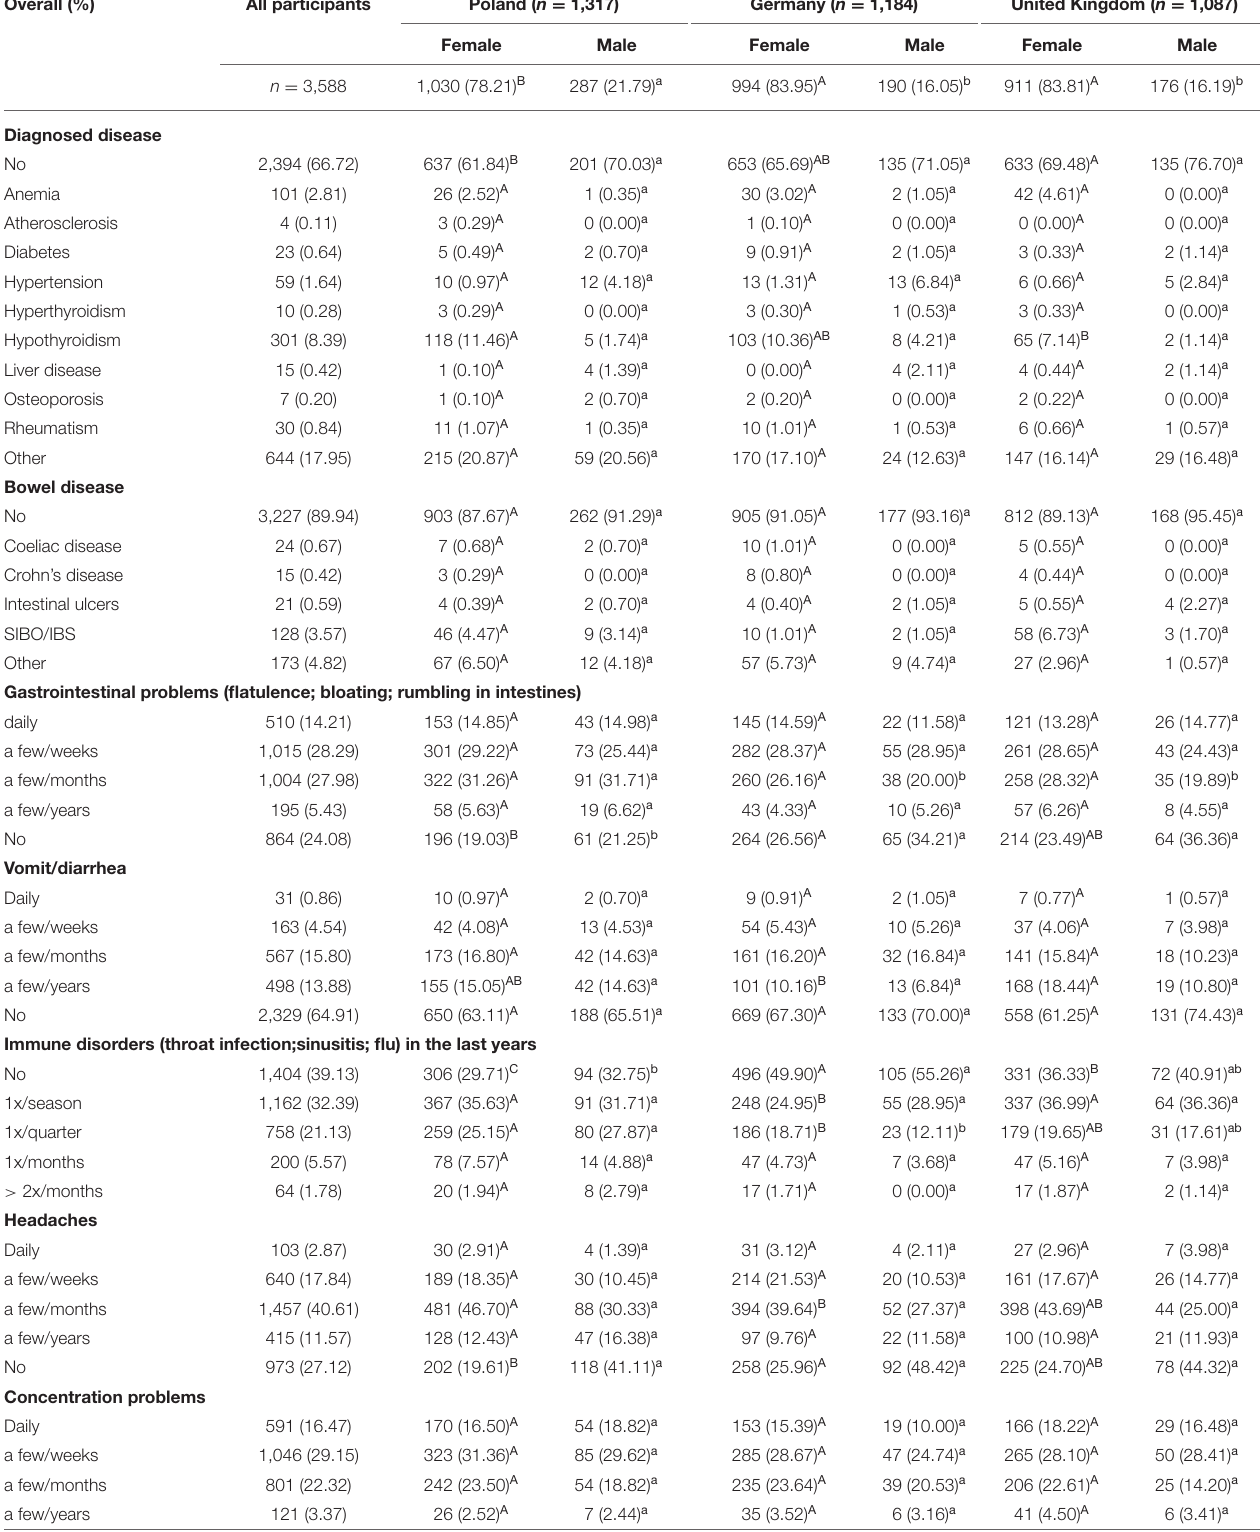
TABLE 4 | Health characteristics of the study